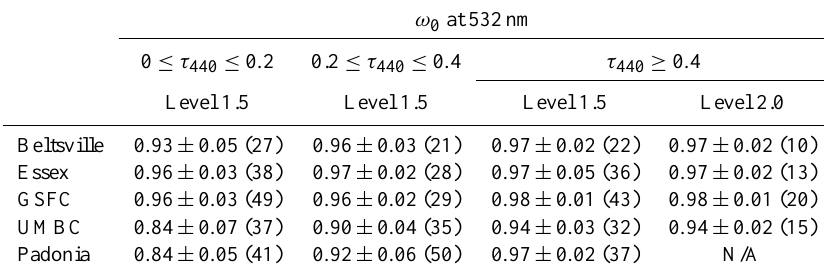
Table 4. July mean values of single-scattering albedo ω 0 for different aerosol loadings and different quality levels for all AERONET/DRAGON stations considered in this